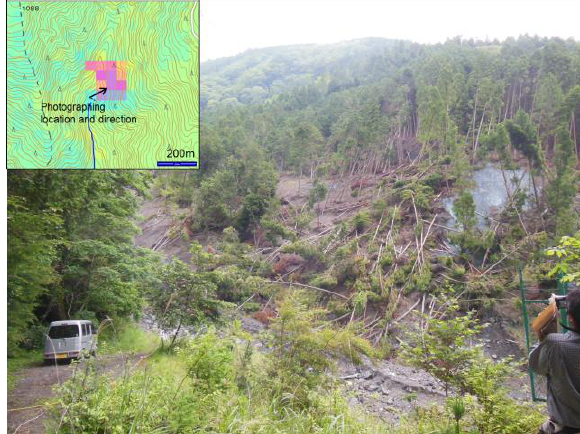
Figure 3. Field photo of landslide collapse in Shizuoka site (June 25, 2013).